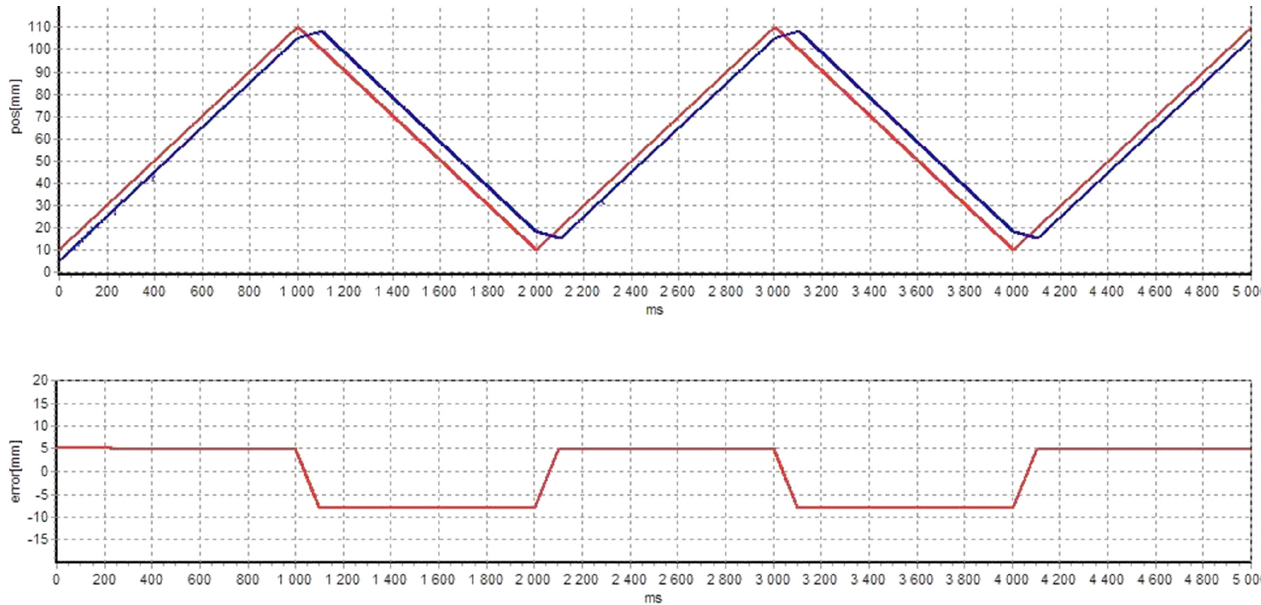
Figure 17. The actuator response to a triangle-shaped input.